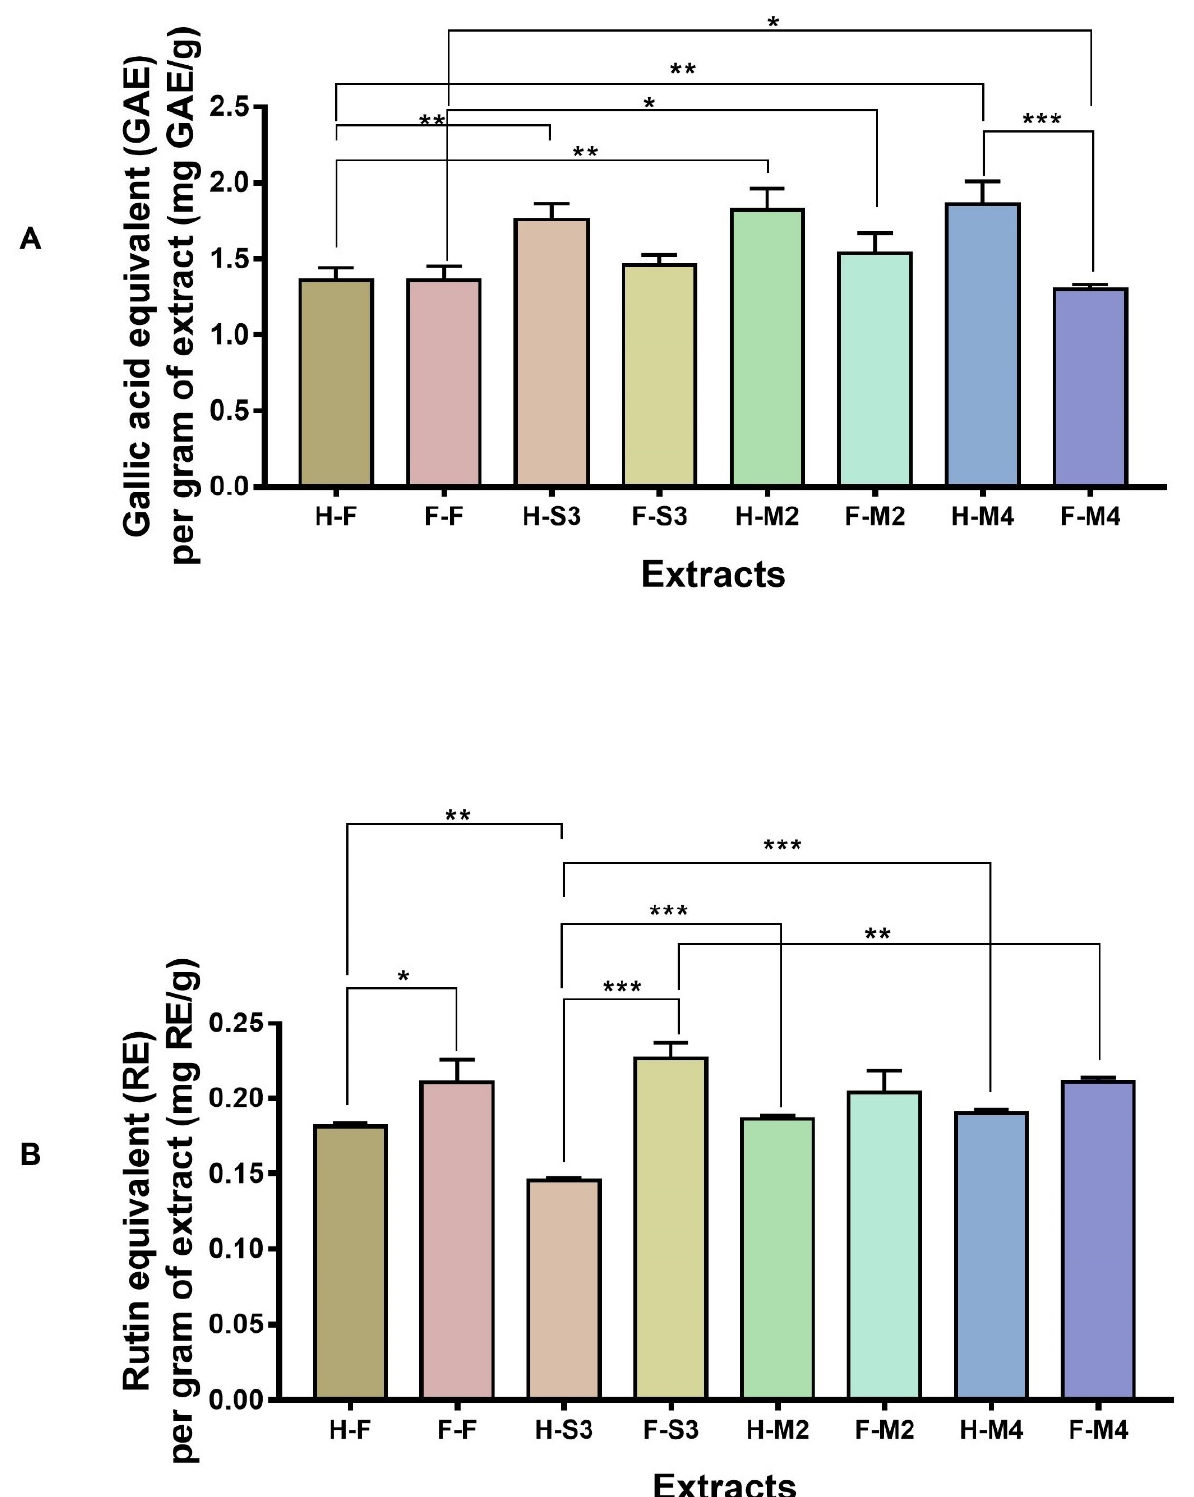
Figure 2. TPC ( A ) and TFC ( B ) of fresh-hot-air-dried (H-F), steamed (3 min)-hot-air-dried (H-S3), microwaved (2 min)-hot-air-dried (H-M2), microwaved (4 min)-hot-air-dried (H-M4), fresh-freeze-dried (F-F), steamed (3 min)-freeze-dried (F-S3), microwaved (2 min)-freeze-dried (F-M2), and microwaved (4 min)-freeze-dried (F-M4) samples. Statistical comparison among groups was carried out using one-way ANOVA with Tukey’s multiple comparison test. * p < 0.05, ** p < 0.01, and *** p < 0.001.